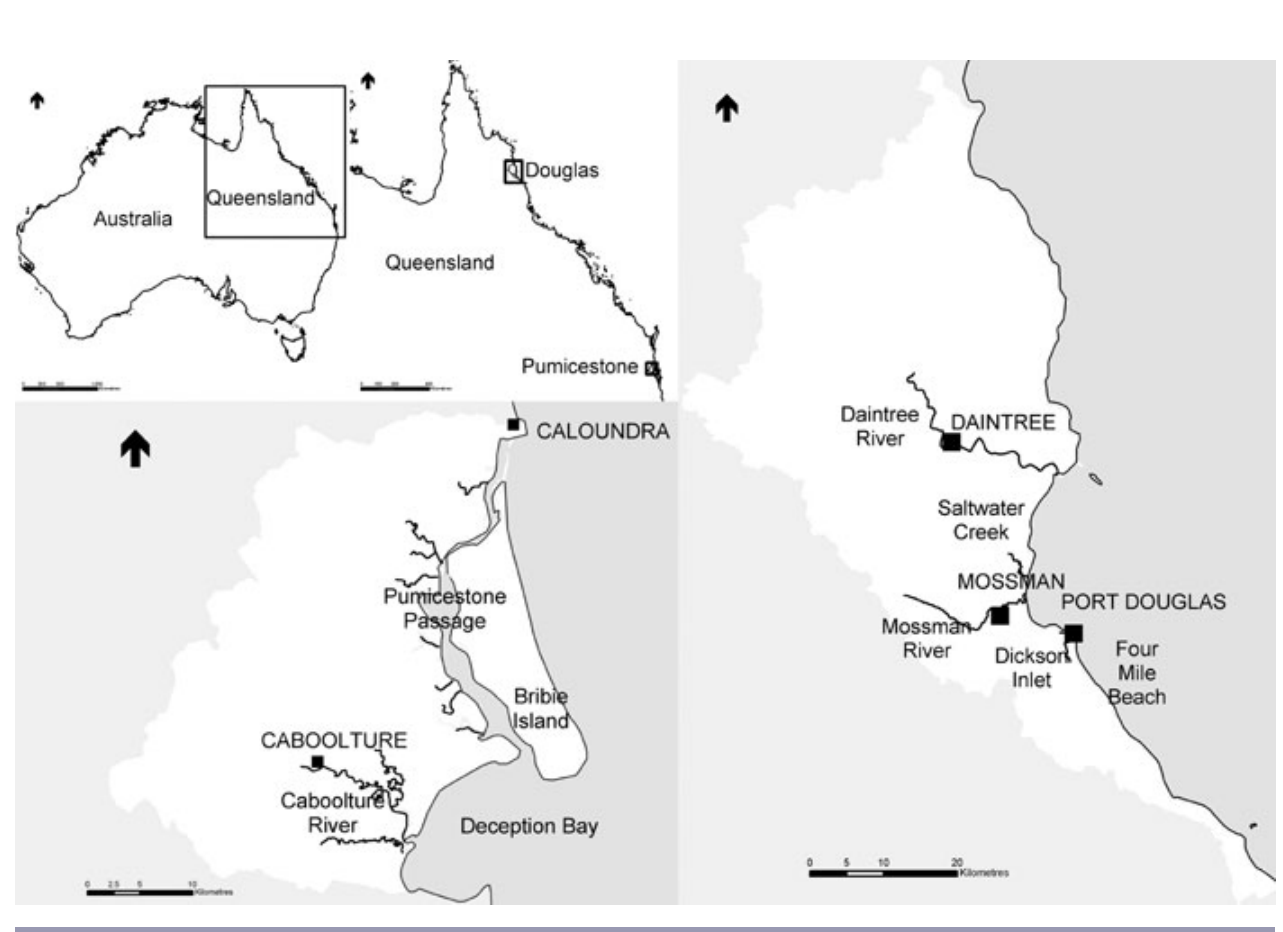
Fig. 2. Maps of the study